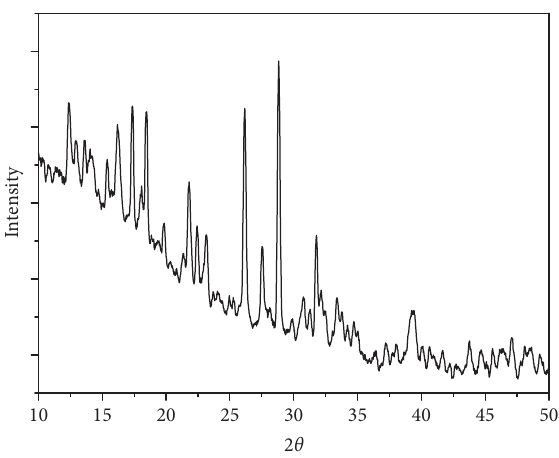
Figure 12: XRD of iron(II) complex.